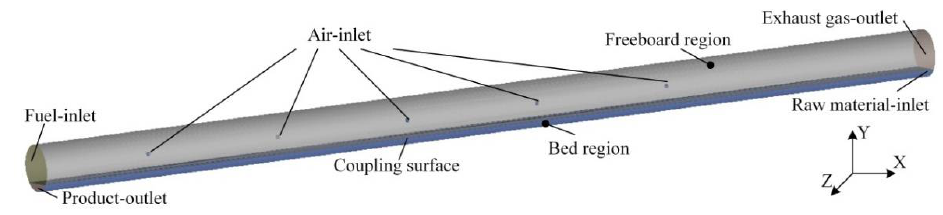
Figure 3. Simplified geometric model of the rotary kiln.